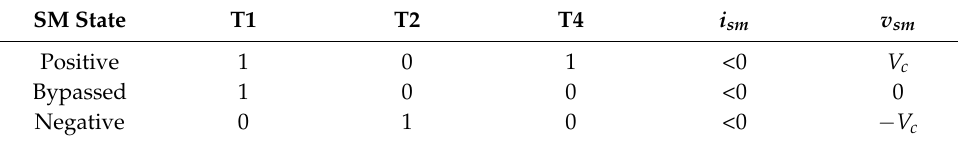
Table 7. UFBSM STATCOM Mode Switching